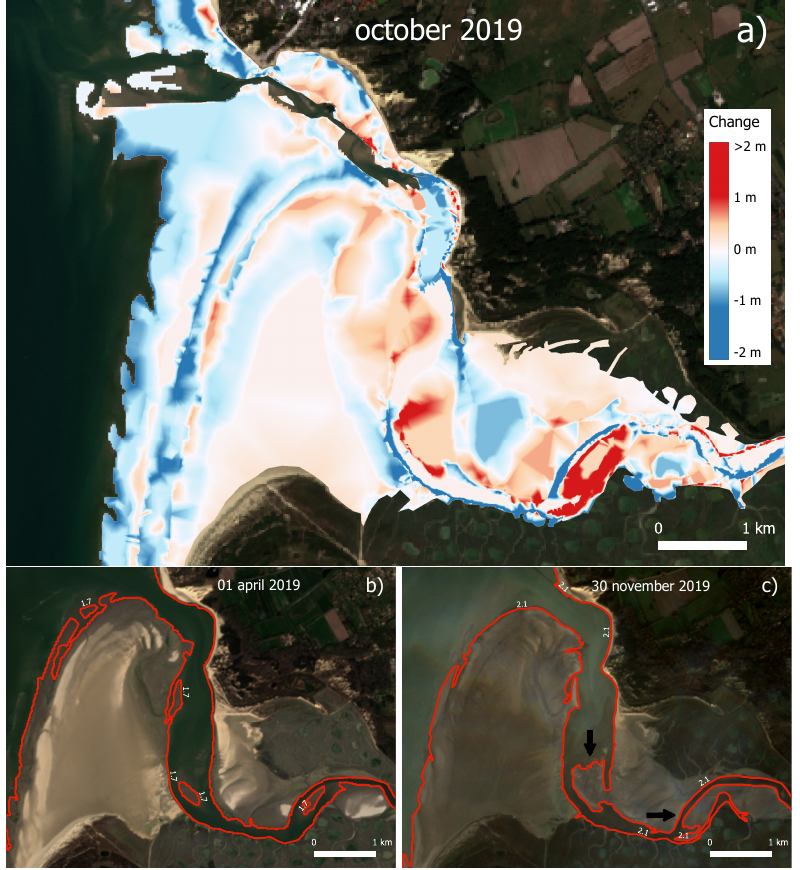
Figure 8. ( a ) Map of elevation changes from February to October 2019. ( b , c ) Sentinel-2 images of intermediate low tide with corresponding waterlines (red lines). Black arrows indicate areas experiencing a high sedimentation phase over the period April to November